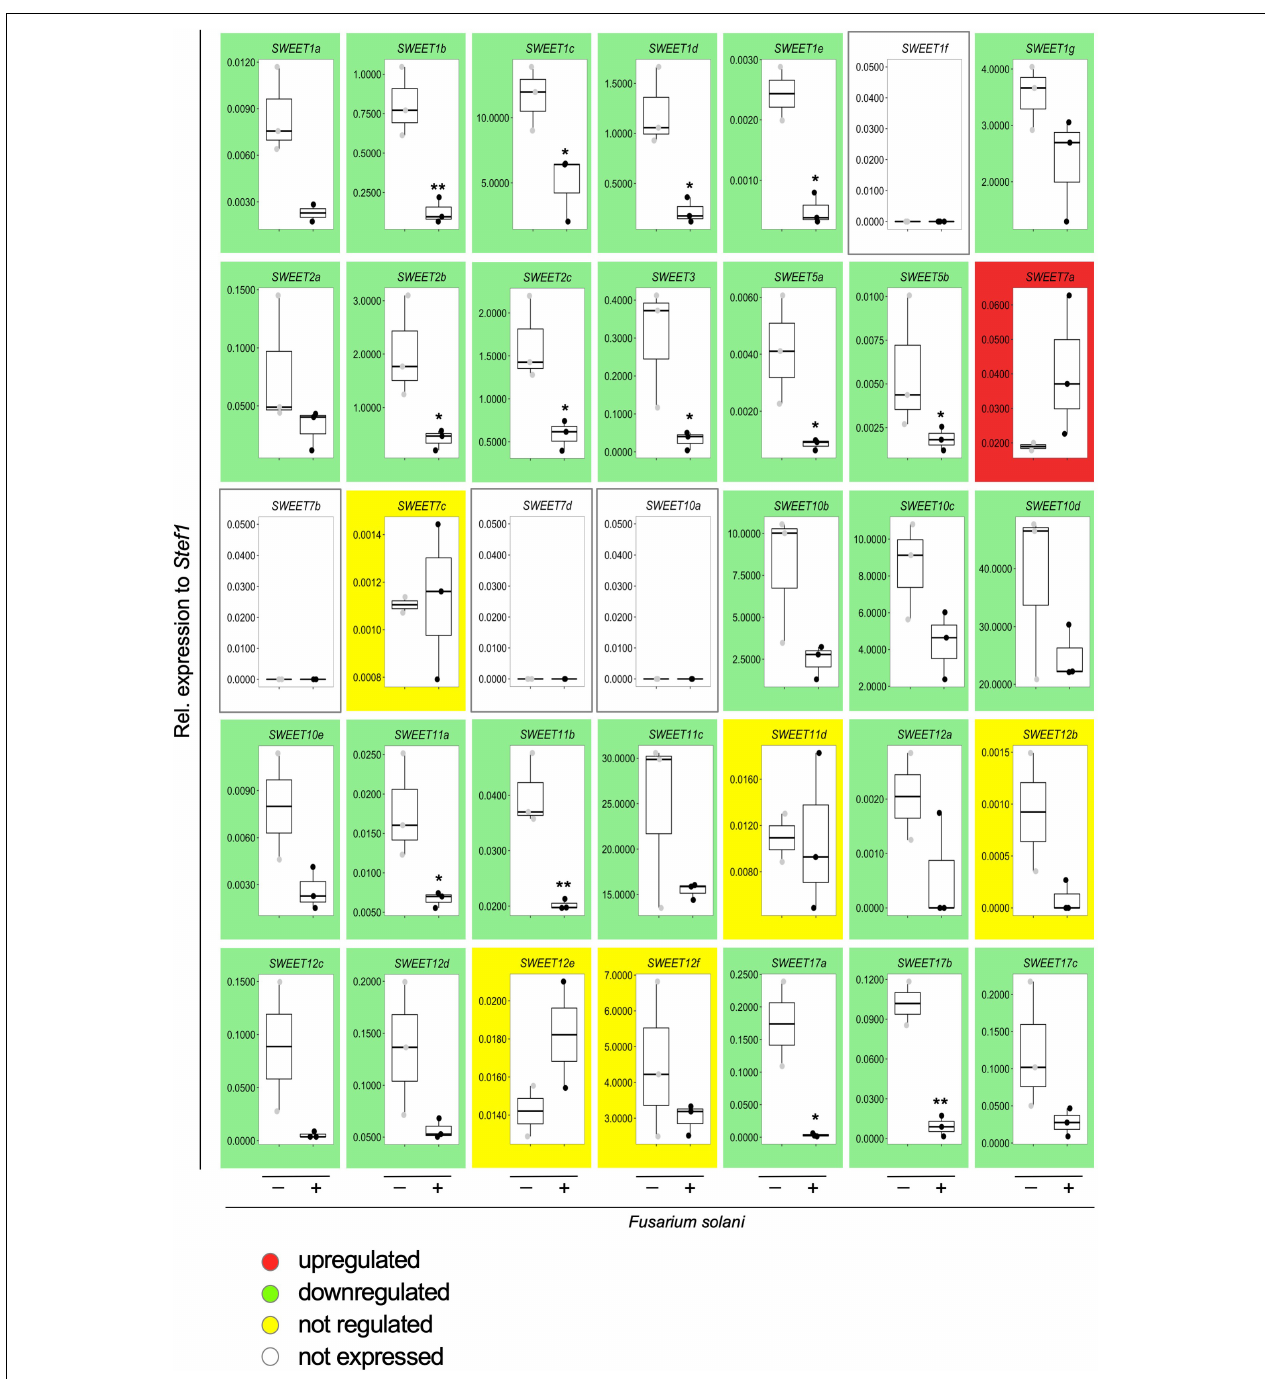
FIGURE 7 | Effect of the infection by the necrotrophic fungus Fusarium solani on the expression of potato SWEET genes. Transcript levels of all potato SWEET genes in response to infection by F. solani were analyzed by qRT-PCR and normalized to StTEF1 . Background color indicates whether the gene at issue is upregulated (red), downregulated (green), not regulated (yellow), or not expressed (white) in response to infection with F. solani . Pairwise comparisons were done with a two-tailed Student’s T -test. Significance is indicated with asterisks, * p < 0.05 or ** p < 0.01.